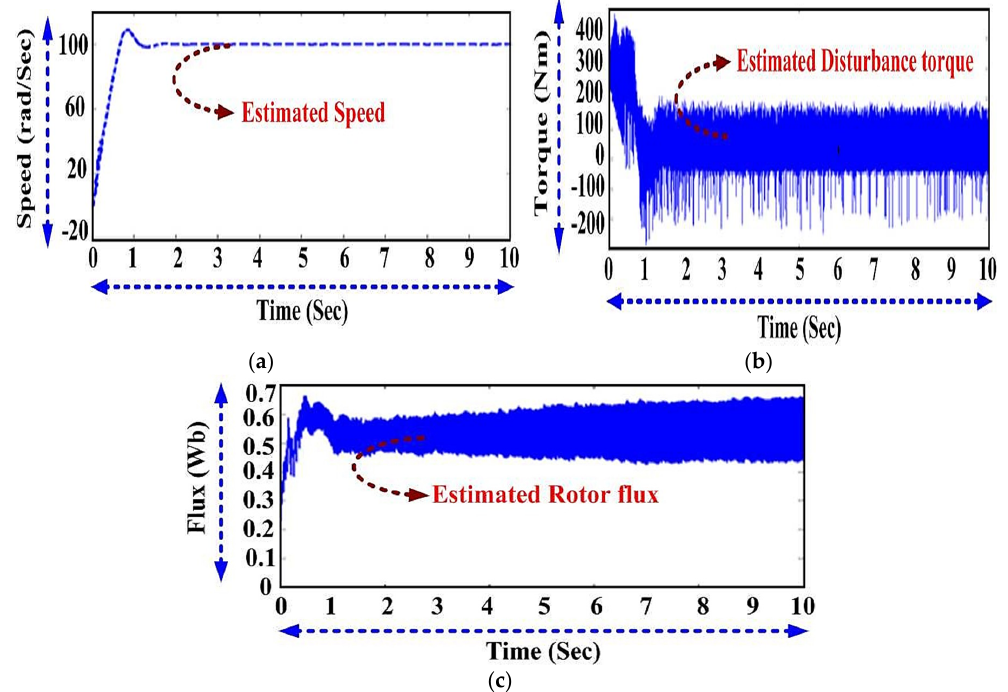
Figure 5. SMLO1: ( a ) estimated speed; ( b ) estimated torque and ( c ) estimated rotor flux.